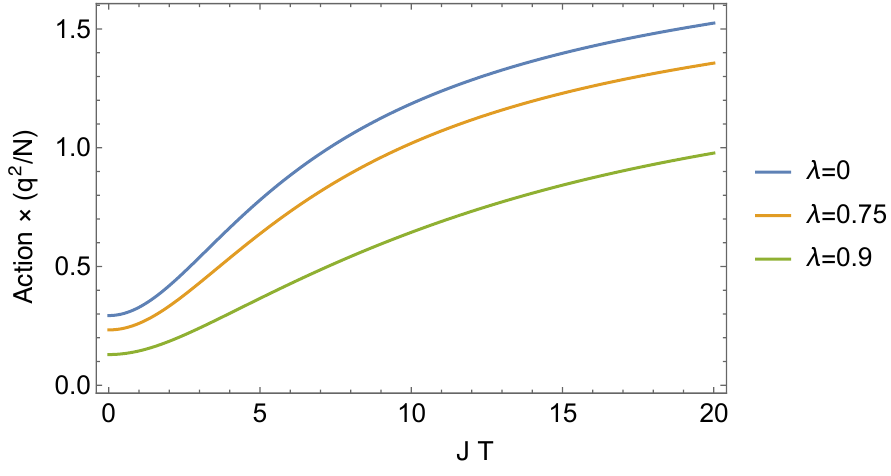
Figure 11 . The large N on-shell action of the disk as a function of J T for β J = 5 for various values of λ . The growth of the action implies that the typical overlap h TFD , J | TFD , J 0 i ∼ e − I is shrinking as a function of time. Smaller values of λ lead to more decorrelated states, which agrees with the larger values of the action. The growth at late times suggests that there is a unitarity problem if we only include the disk